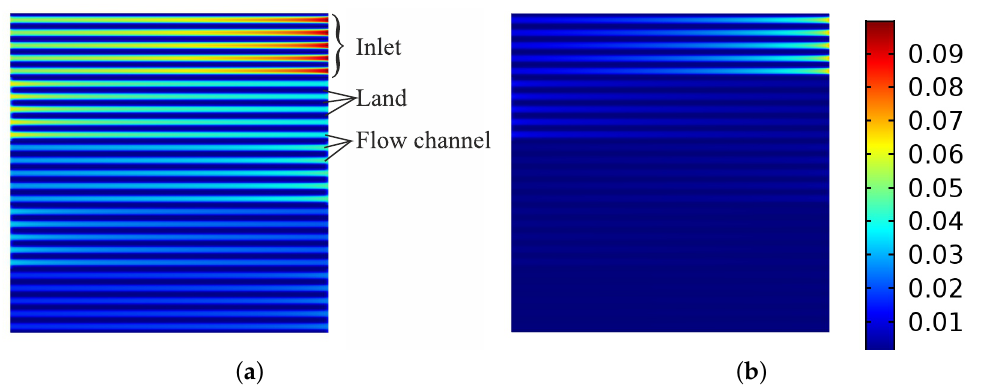
Figure 11. Molar concentration of oxygen at the agglomerate surface c S in molm − 3 at 5m Ω , active cell area at the CL/GDL interface ( a ) with the cathode supply in accordance to the experimental conditions and ( b ) with a stoichiometry of 2.5 according to the